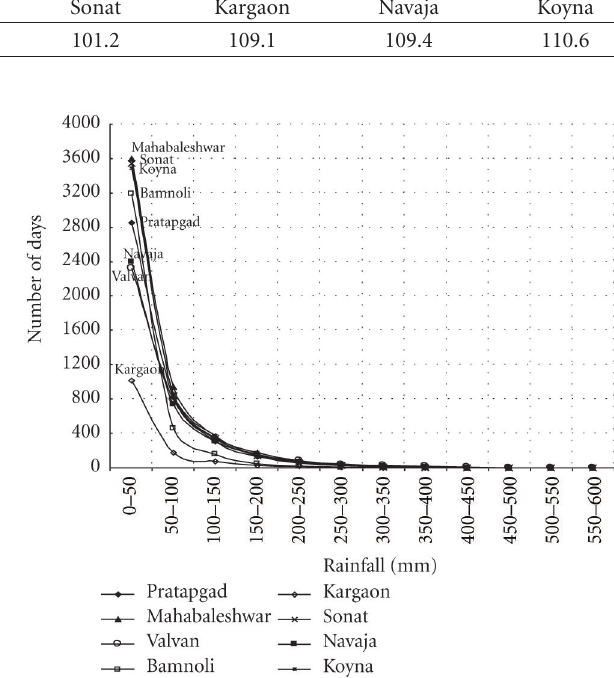
Figure 6: Yearly frequency of number of rain days at eight stations in the Koyna catchment. Figure 7: Frequency distribution of daily rainfall over the Koyna